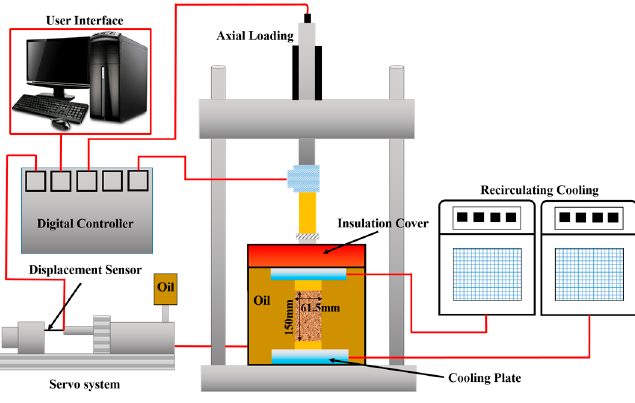
Figure 4. Schematic diagram of the triaxial shear apparatus